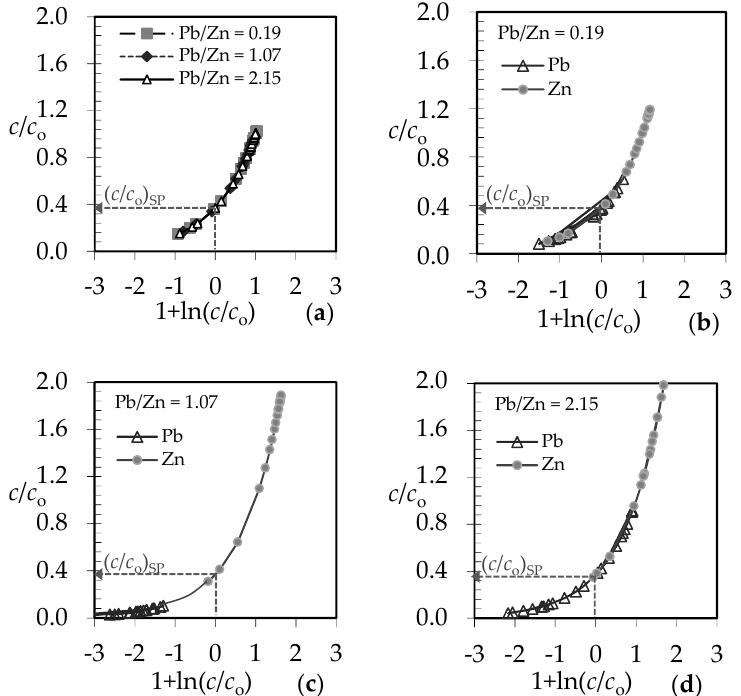
Figure 12. Qualitative evaluation of the rate-controlling step for (Pb+Zn) binary systems at different Pb/Zn ratios: ( a ) for the total (Pb+Zn) concentration; ( b – d ) for each ion in the (Pb+Zn) system.